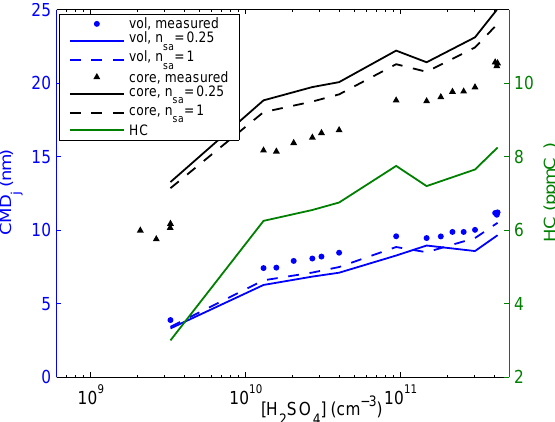
Figure 11. Measured and simulated CMD vol and CMD core and hy- drocarbon vapor amount in raw exhaust as a function of raw exhaust sulfuric acid vapor concentration in R cases. Measurement data are obtained from Rönkkö et al. (2013).